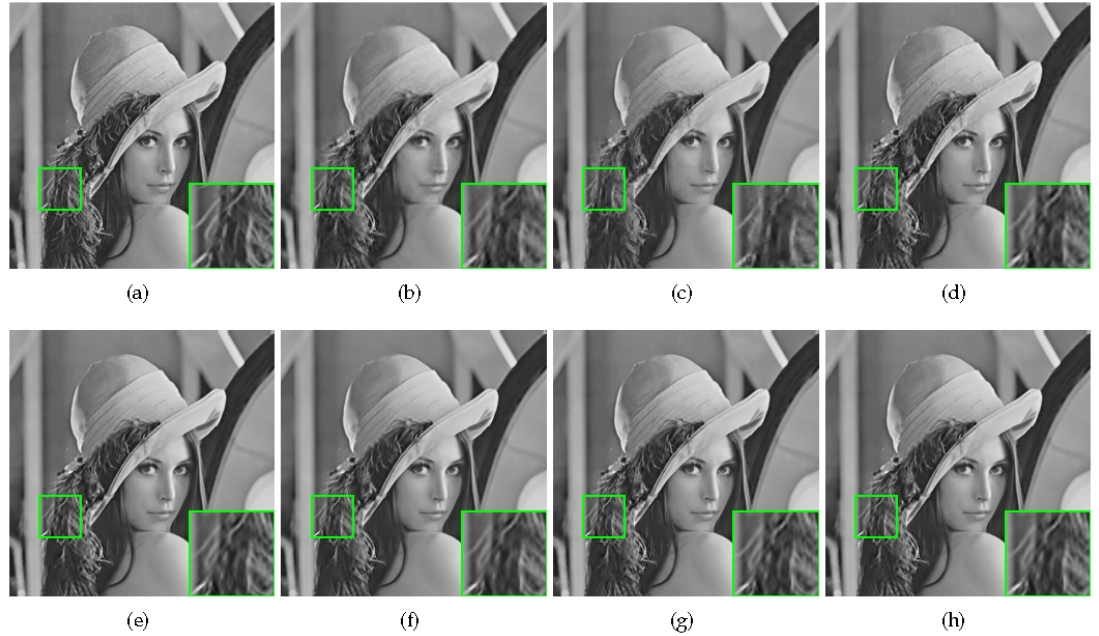
Figure 7. Reconstruction of Lena with sampling rate = 0.3. ( a ) Original image; ( b ) MH (PSNR = 31.99 dB, FSIM = 0.9538); ( c ) RCoS (PSNR = 32.41 dB, FSIM = 0.9555); ( d ) ALSB (PSNR = 33.30 dB, FSIM = 0.9650); ( e ) GSR (PSNR = 34.17 dB, FSIM = 0.9716 ); ( f ) JASR (PSNR = 34.05 dB, FSIM = 0.9677); ( g ) GSR-NCR(PSNR = 33.94 dB, FSIM = 0.9715); ( h ) Proposed HNLSR (PSNR = 34.27 dB, FSIM = 0.9716